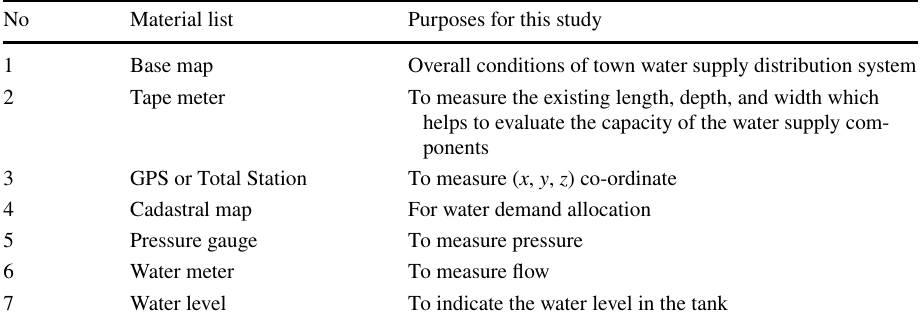
Table 1 Materials utilized in this investigation and their intended uses